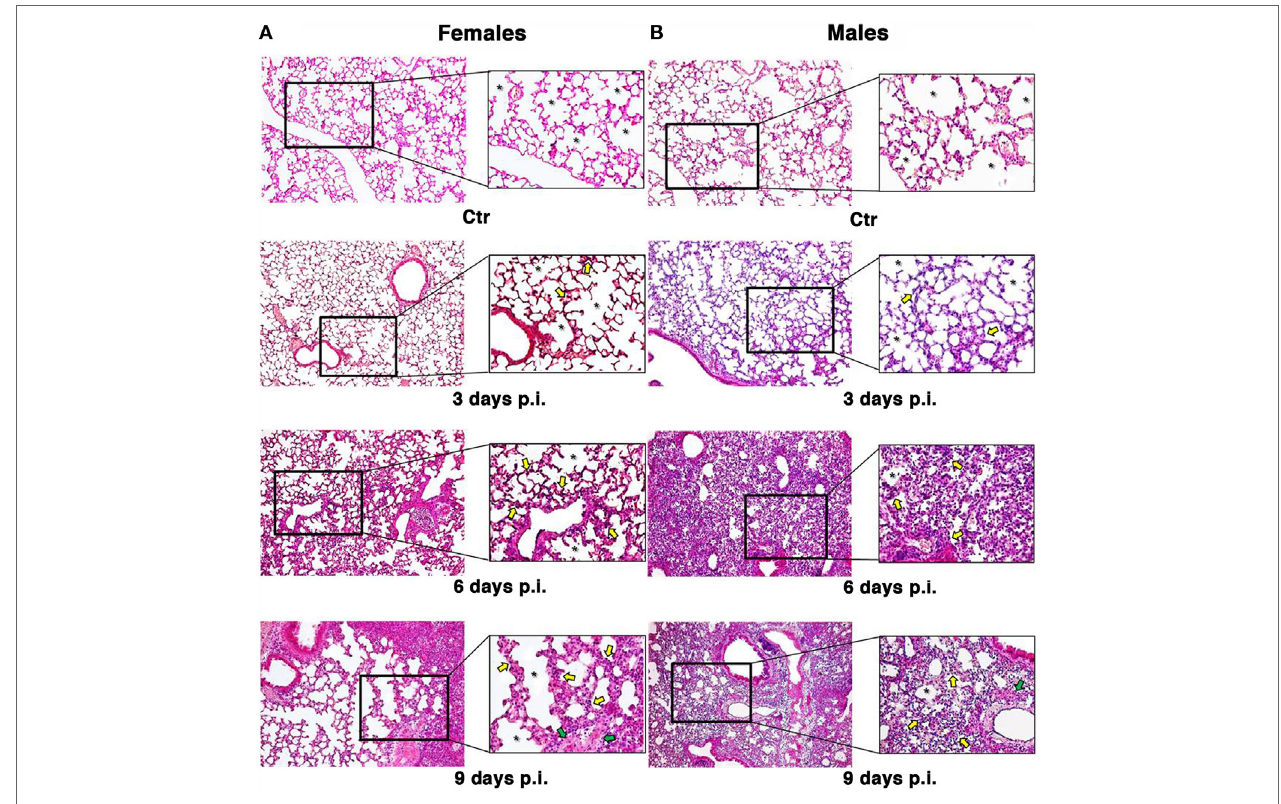
FigUre 2 | Influenza A virus produces more severe lung damage in male mice. Hematoxylin & eosin-stained section of the female (a) and male (B) pulmonary tissues from mock-infected (Ctr) or infected mice with influenza A virus and sacrificed at different times (3, 6, and 9 days). Early structural changes caused by influenza virus in the epithelium of the lower airway are variable, with cytonecrosis involving shrinkage, decreasing in alveolar surface, followed by desquamation of these cells into the luminal space. In addition, there is necrosis of the bronchiolar wall, with submucosal edema and vascular congestion. These structural changes are irregularly distributed among male and female mice. In fact, the female mice (a) sacrificed after 3 days still show an higher amount of alveolar surface (see the asterisks) with some initial alterations, such as thickening of the alveolar septa and inflammatory infiltration (see yellow arrows) compared to the control and the corresponding male samples (B) . After 6 days, we found an increase in inflammation both in male and female mice, the epithelial layer is desquamating, and necrotic epithelial cells are present in the lumen (see green arrows). But, in male (B) , massive pulmonary edema and hemorrhage with the alveolar air spaces fill of edema fluid and erythrocytes are also present. After 9 days, the male tissue presents a slight worsening of the previous features, whereas the female lungs start to display the same aspects, maintaining a greater alveolar area (original magnification 10 ×